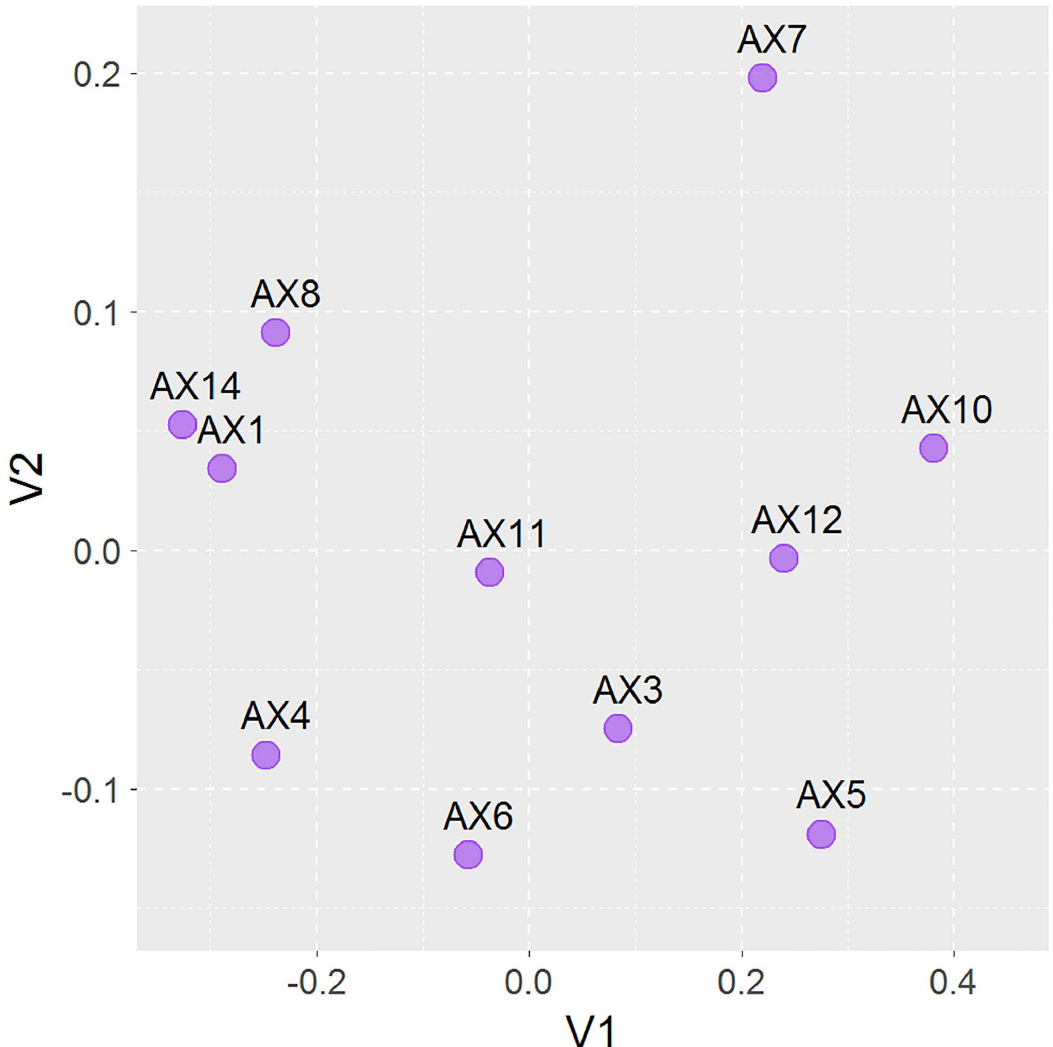
Fig 4. Genetic distance-based scaling plotting of pair wise comparisons according to their genetic relatedness among 11 studied hog deer.